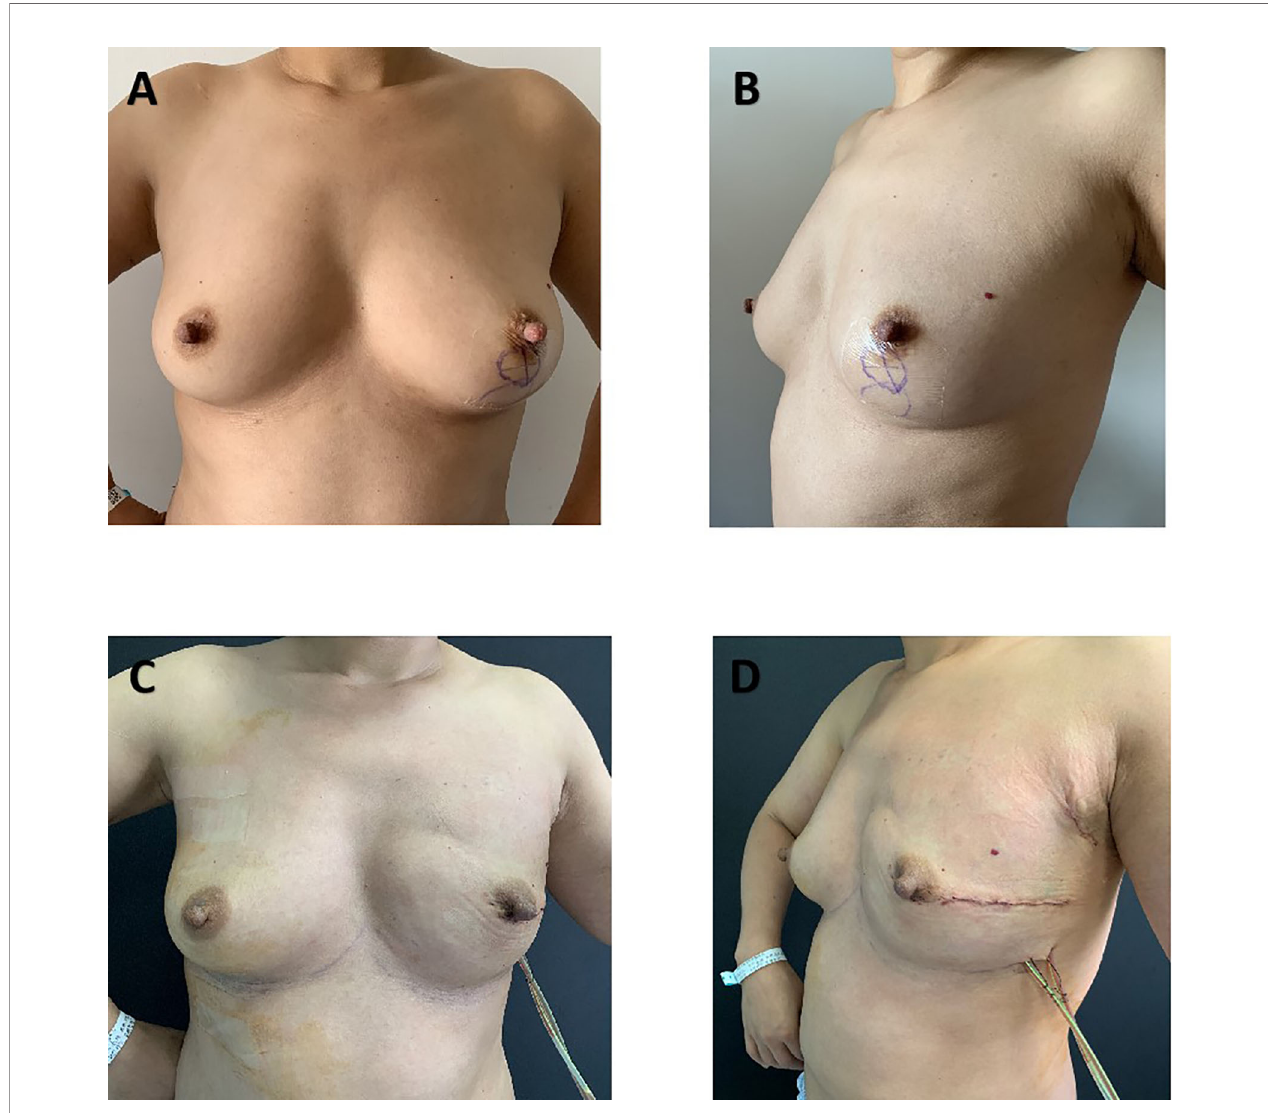
FIGURE 4 | Unilateral left nipple-sparing mastectomy and immediate direct-to-implant breast reconstruction with SIS matrix. A 40-year-old woman who was diagnosed with invasive carcinoma and was treated with neoadjuvant chemotherapy before surgery (A, B) . Photos at 7 days postoperatively (C, D) .